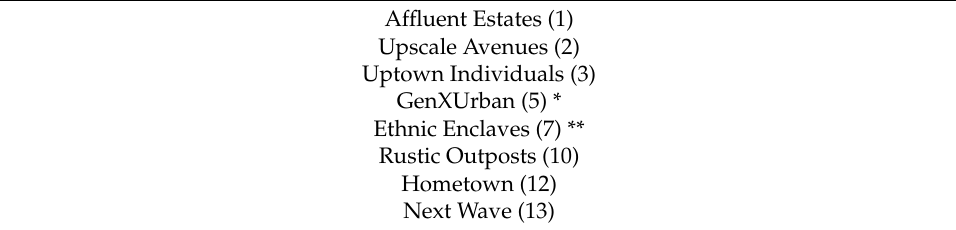
Table 3. High-risk LifeModes for COVID-19 infection and